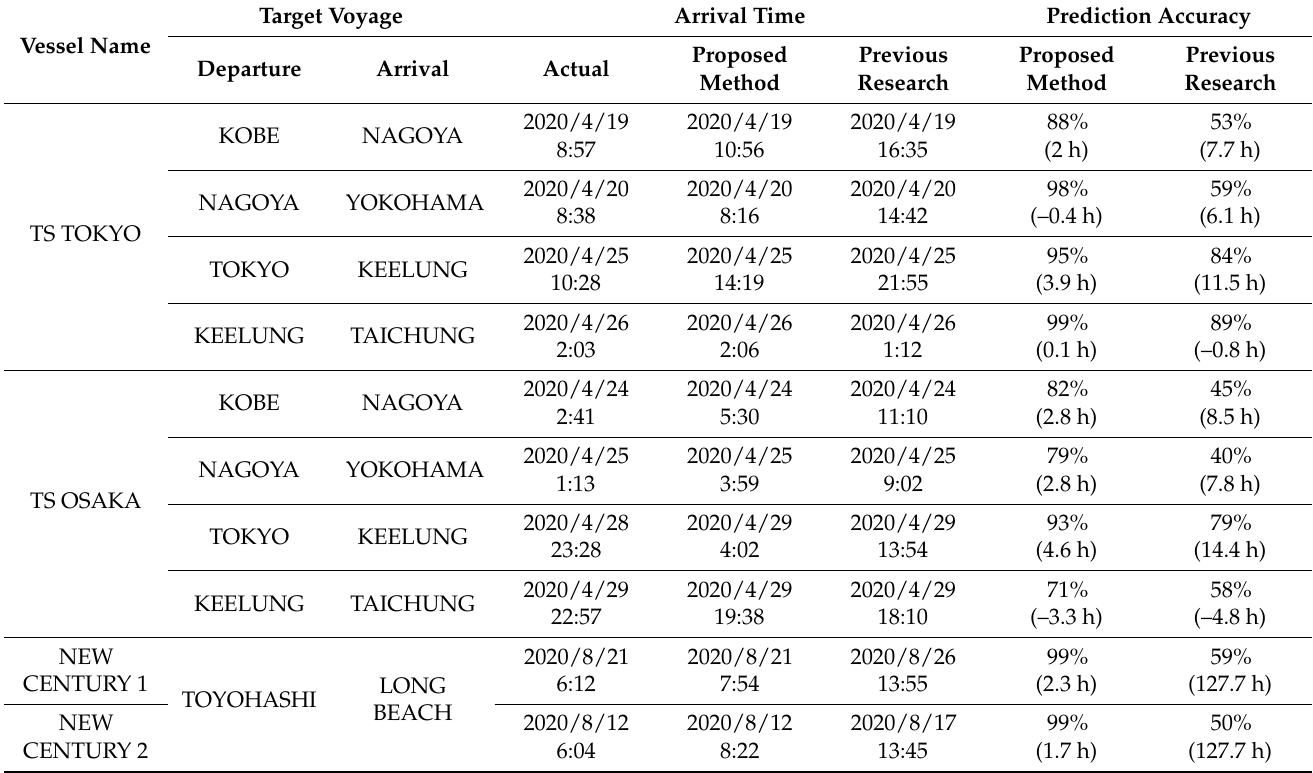
Table 4. Comparison of prediction